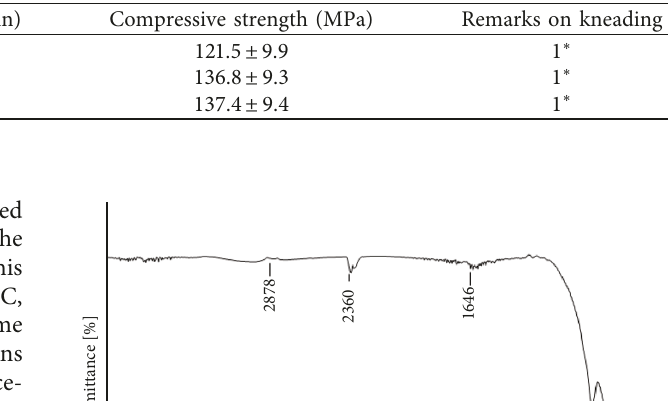
2 were used as the agent providing